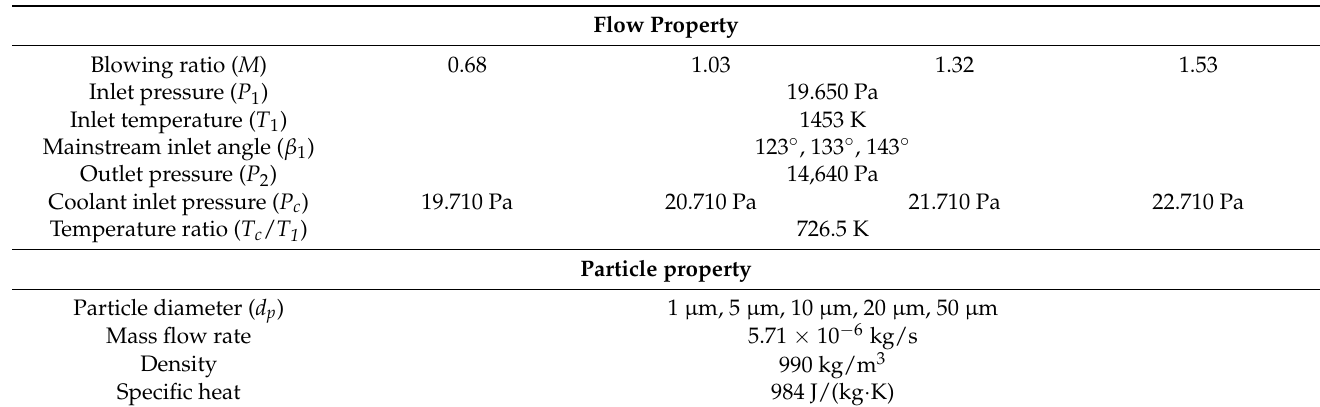
Table 2. Boundary condition and particle properties.